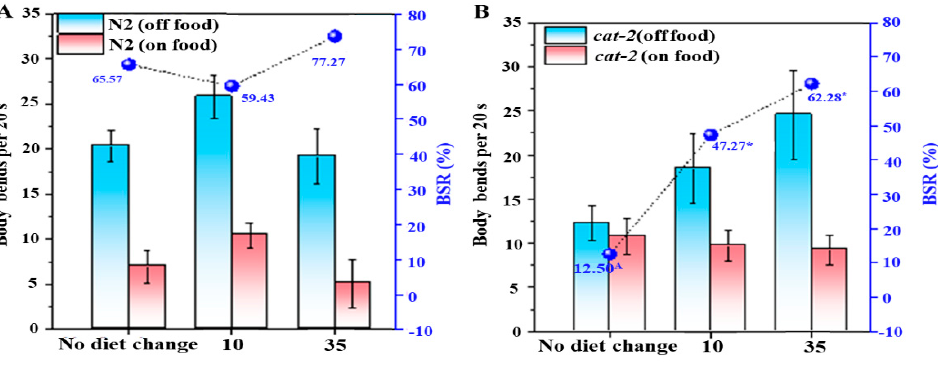
Figure 3. Improvement in DA-regulated behavior, BSR, in C. elegans by CUHNP. Body movement (left y-axis, bends per 20 s) and basal slowing response (BSR) percentage (right y-axis) of wild-type N2 ( A ) and cat-2 (e1112) mutant ( B ) C. elegans fed without nanoparticles and with 10 µ g/mL and 35- µ g/mL CU-loaded HSA nanoparticles (CUHNP), respectively. The data present the mean ± S.D. from three independent experiments ( p < 0.01). * means exhibited enhanced BSR within worm strain group, and A represents a defect in BSR compared to in wild type samples.